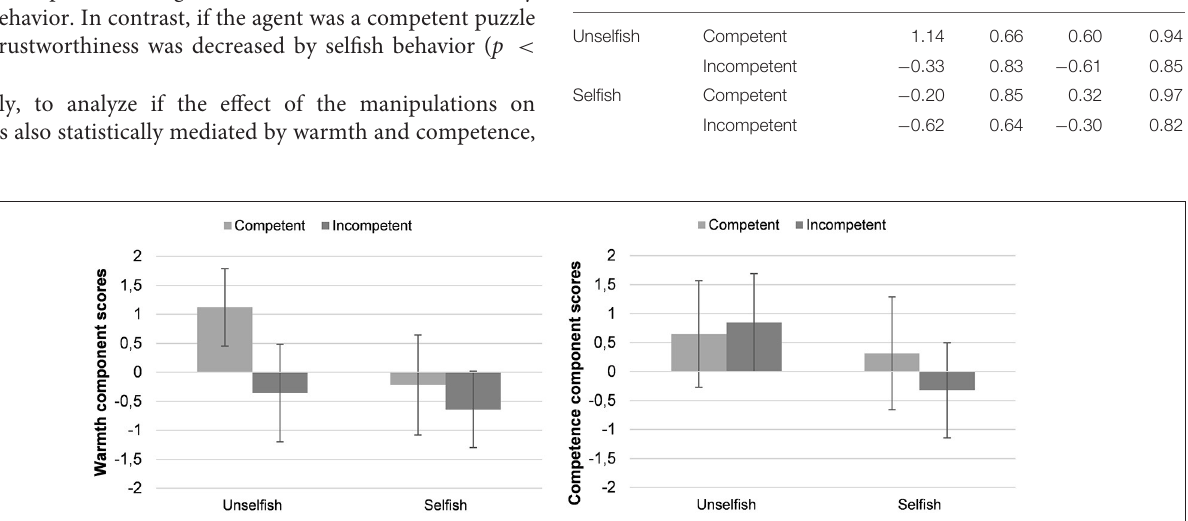
Frontiers in Digital Humanities |